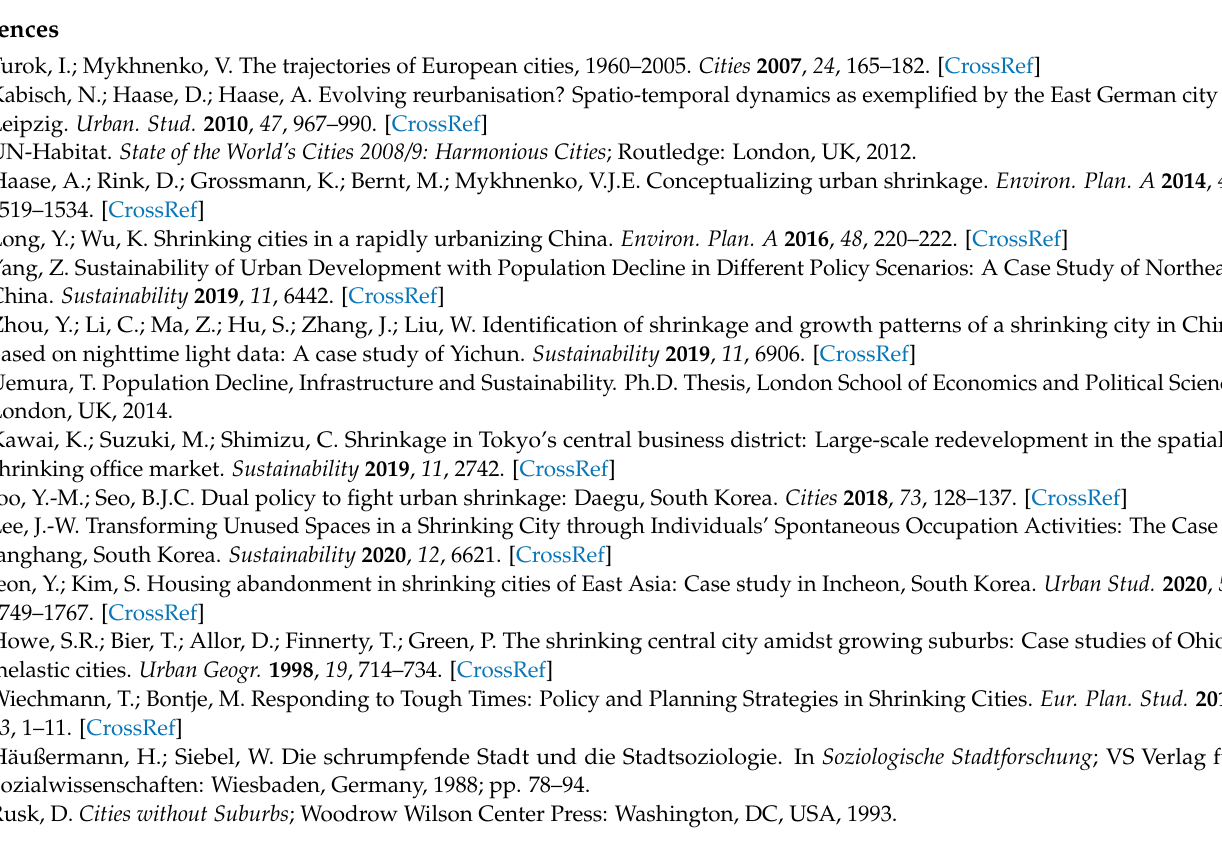
Figure A3. Comparison of